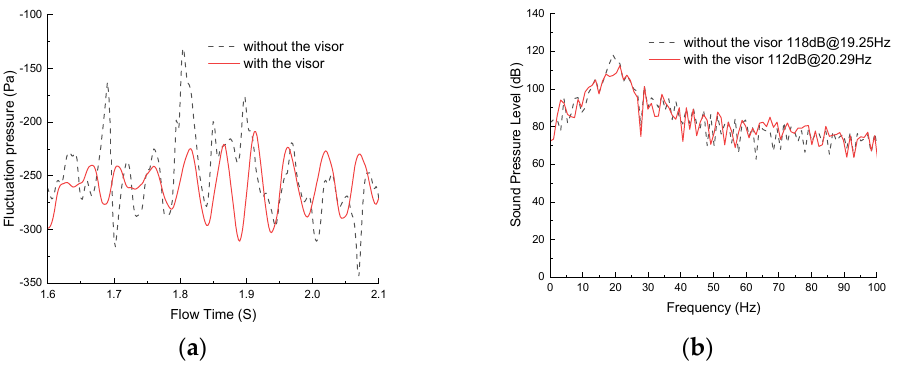
Figure 6. Vorticity on the horizontal plane through the driver’s ear. ( a ) Without the visor; ( b ) With the visor.